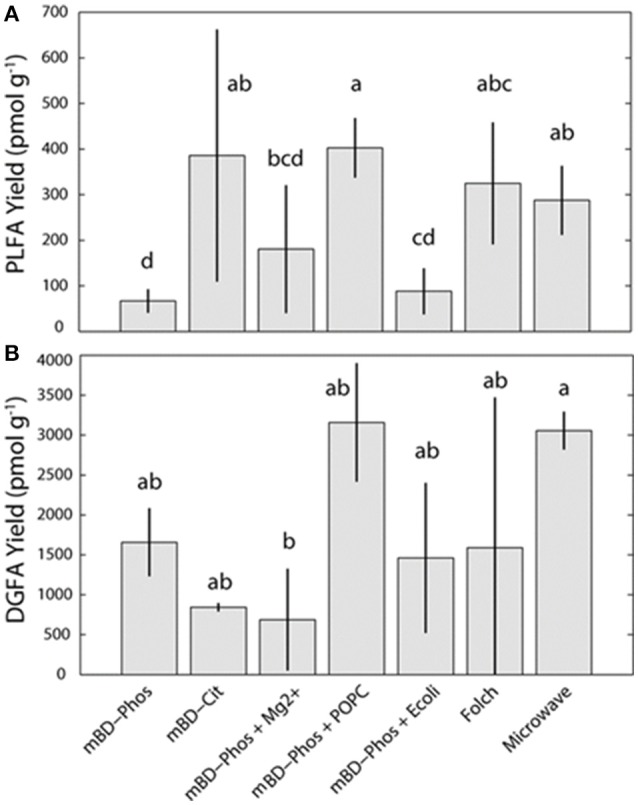
Average PL (A) and DG-FAMEs (B) for each extraction treatment method (n = 7). Error bars represent the standard deviation between replicates. Shared letters indicate no significant differences in mean concentration, based on ANOVA and Tukey-HSD tests (α = 0.05), are plotted above each bar.